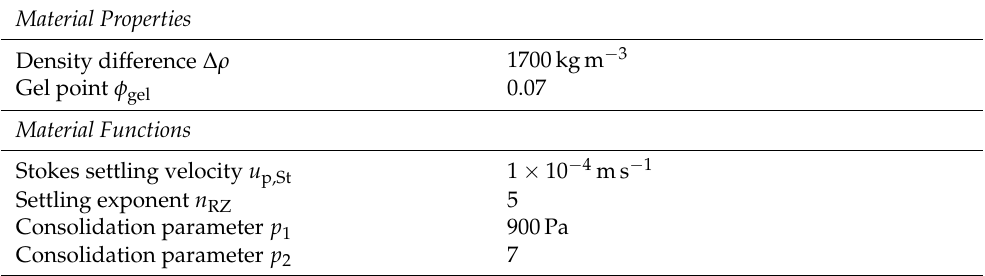
Table 1. Material characteristics and process conditions concerning the investigation of Bürger and Concha